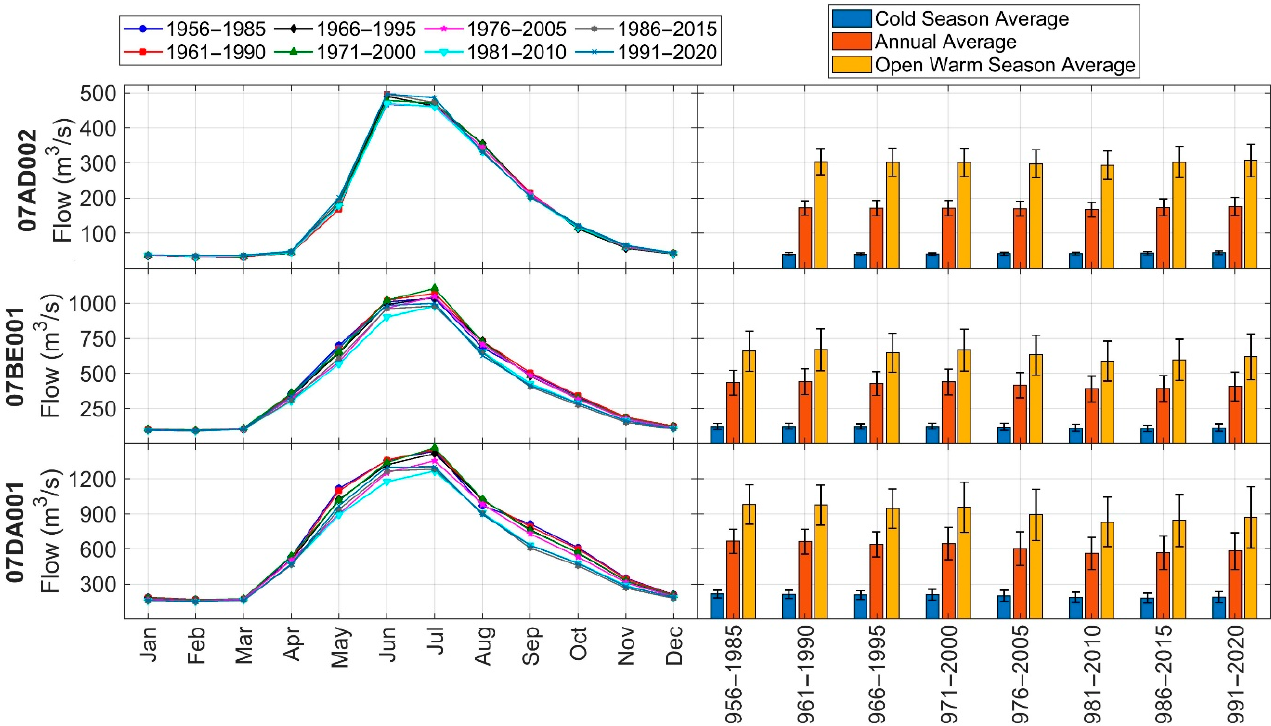
Figure 7. Hydrographs (left panels) and seasonal averages with the standard deviation (right panels) of stations 07AD002 (u3), 07BE001 (m6), and 07DA001 (l2), which represent the upper, middle, and lower ARB, respectively.